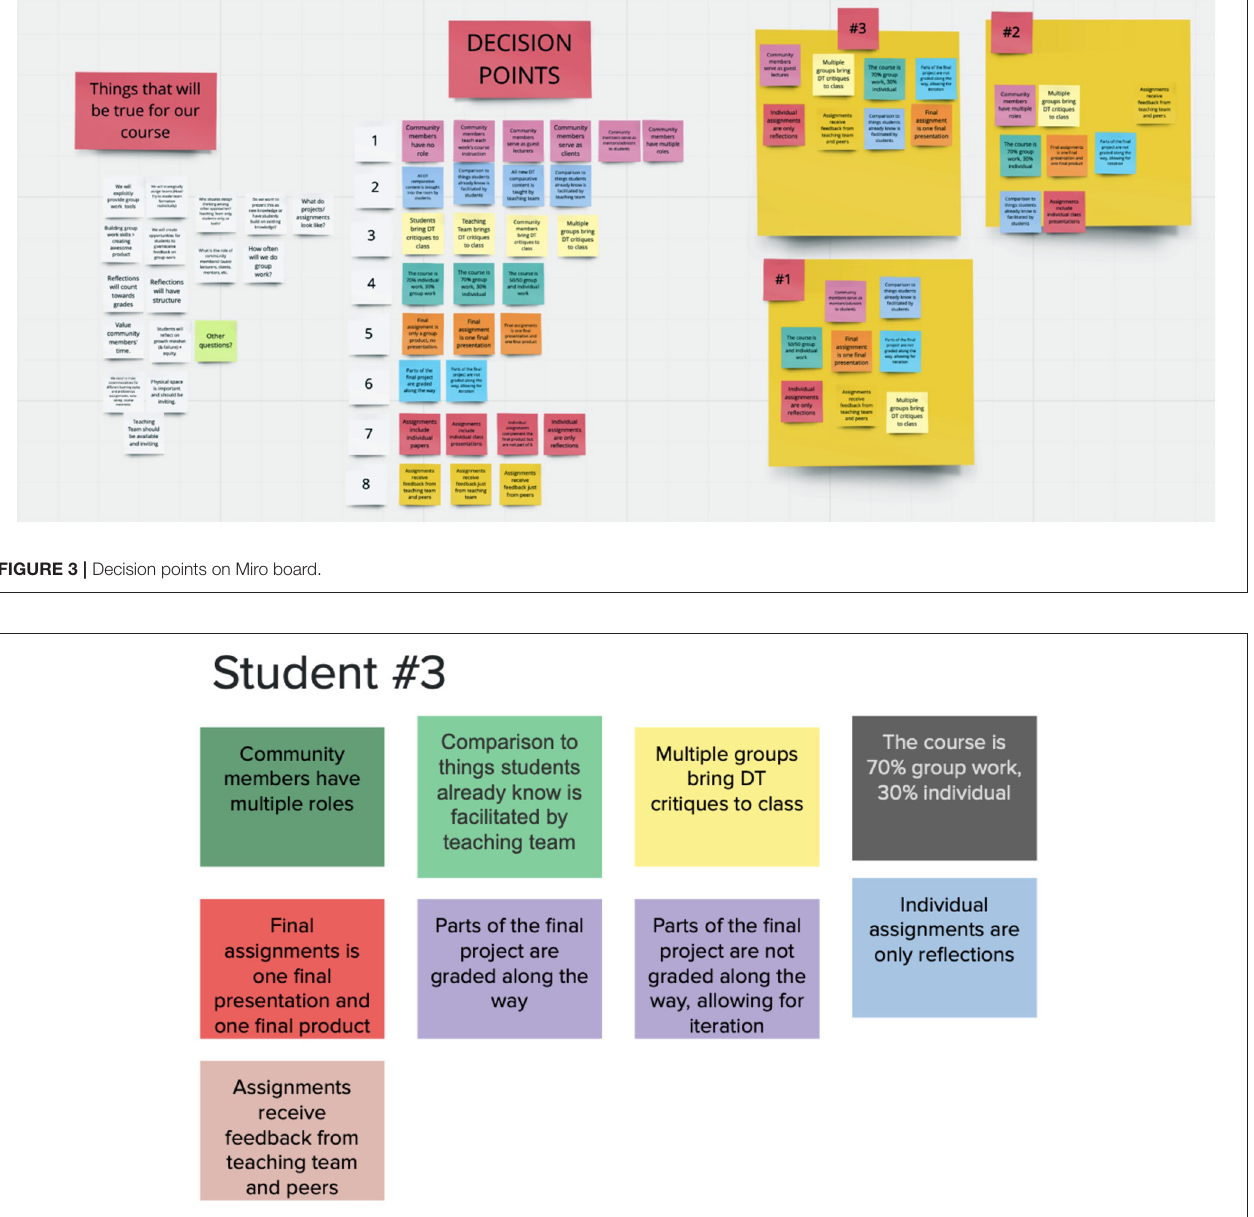
FIGURE 4 | Graduate student course concept from co-creation